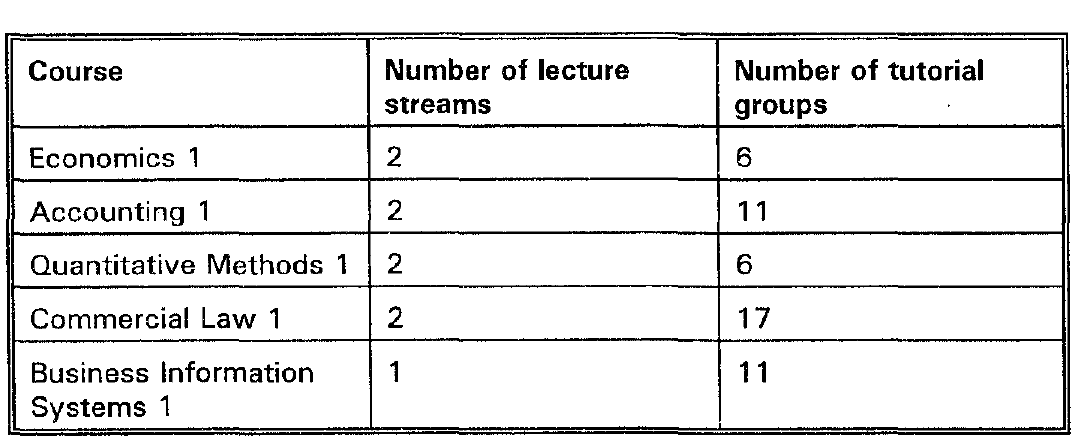
Table 1. Specimen first year curriculum in Commerce Faculty